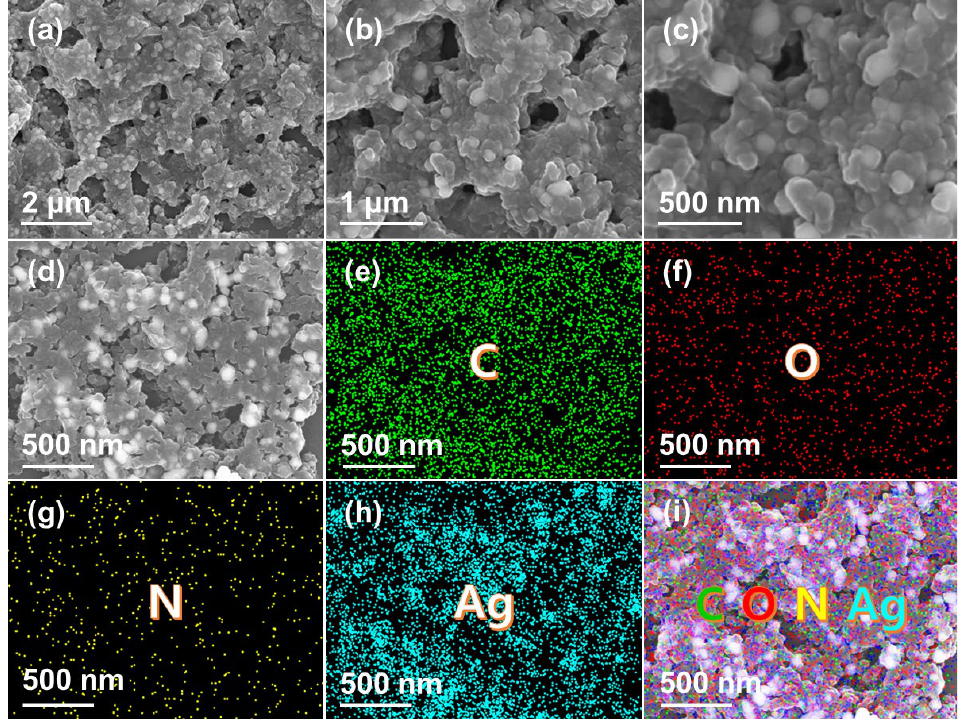
Figure 2. ( a – c ) FESEM images of the synthesized CDs@AgNPs; ( d ) FESEM electron image and ( e – h ) the corresponding elemental mapping; and ( i ) overlapping image of all elements ( d – h ) of the synthesized CDs@AgNPs.